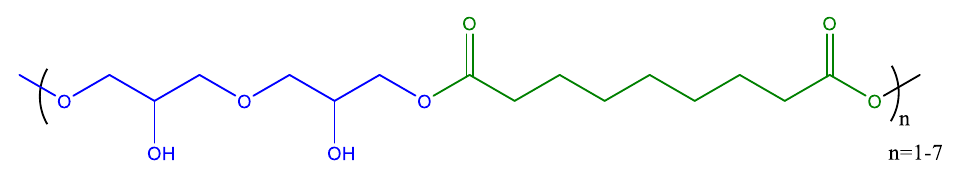
Figure 2. Chemical structure of the polyglycerol-azelaic acid polyesters obtained using diglycerol and different vegetable oils as raw materials.